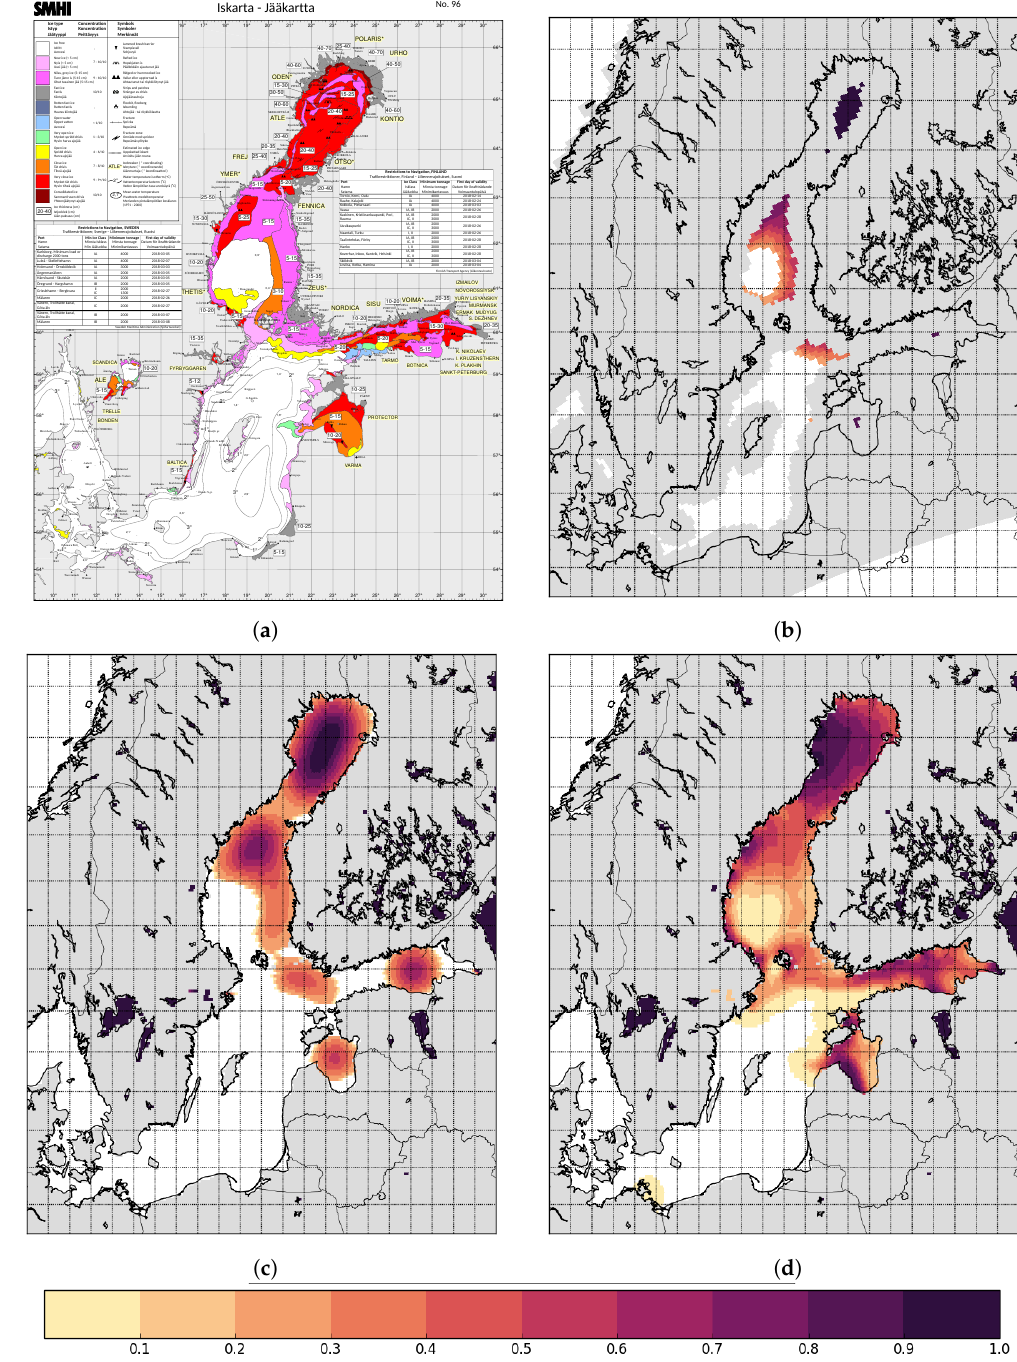
Figure 14. ( a ) Manually produced Finnish–Swedish ice chart of the Baltic Sea. © [44] Reproduced with permission. ( b ) OSI SAF 401-b product. Note missing data (grey) around coastlines due to coastal contamination in satellite retrievals of sea ice concentration. ( c ) Uncoupled analysis. Note the Gaussian nature of the ice field centred on the available OSI SAF L3 observations. ( d ) WCDA. Note the much more realistic structure and the good agreement with the manual ice chart. As in Figure 13 but on 5 March 2018, the date of maximum sea ice extent in the region for the